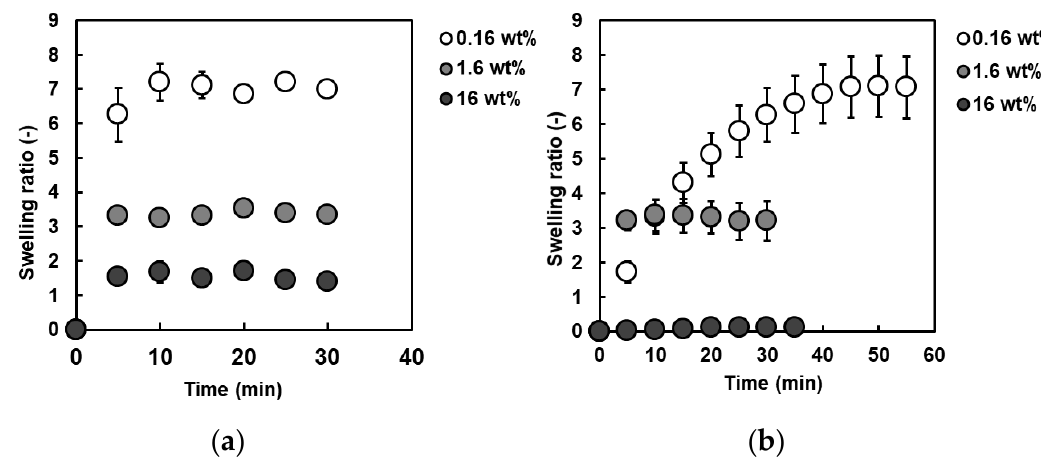
Figure 7. Water absorption of PSA nanofiber meshes and films prepared with different crosslinker concentrations in PBS (pH: 7.4). Ethylene glycol concentration: closed circle; 16 wt%; shaded circle, 1.6 wt%; and open circle, 0.16 wt%; respectively. Data are expressed as mean ± standard deviation (SD) (n = 40). Absorption of PAA nanofiber mesh / film in phosphate bu ff ered saline (PBS): ( a ) fiber; ( b ) film.